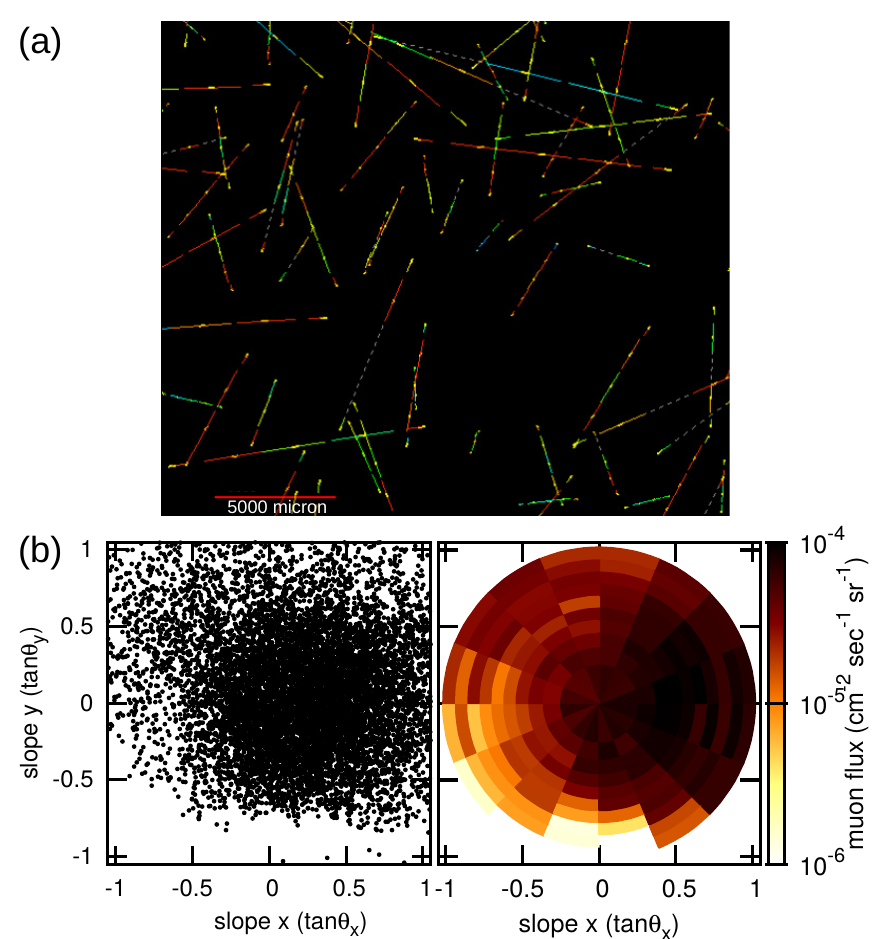
Figure 12. ( a ) muon tracks reconstructed in a module. The yellow segments represent the base-tracks; ( b ) muon angular distribution (left) and flux obtained with the detector D3